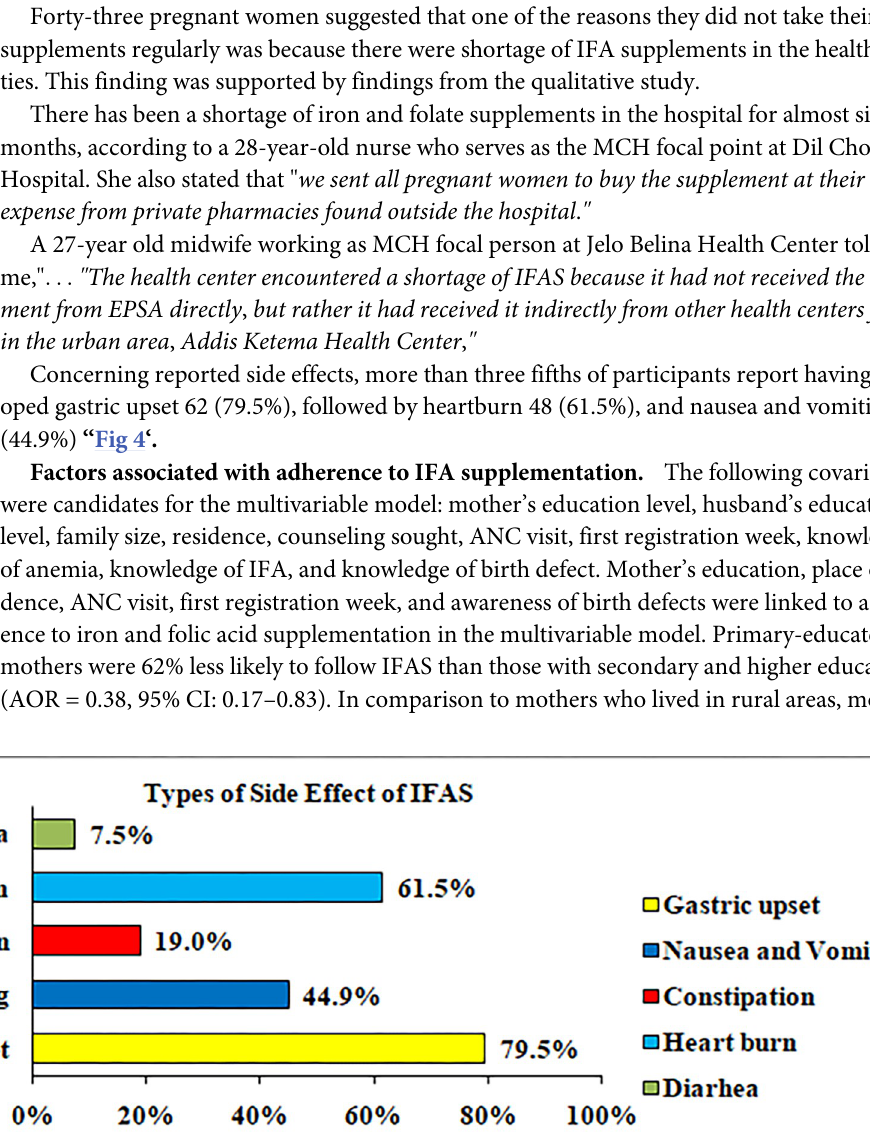
PLOS Global PublicHealth | https://doi.org/10.1371/journal.pgph.0000825 January18,